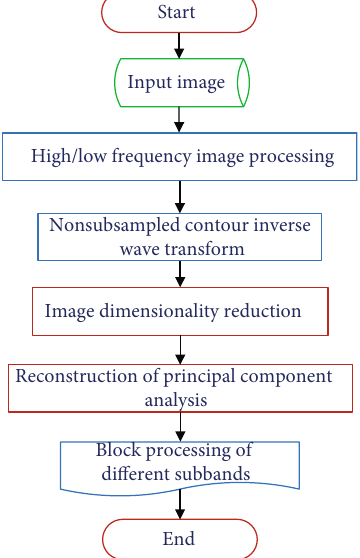
Figure 3: Image recognition process based on partial di ff erential